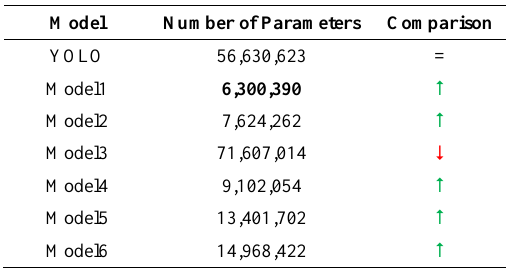
Table 1. Comparison of results for the number of learnable parameters